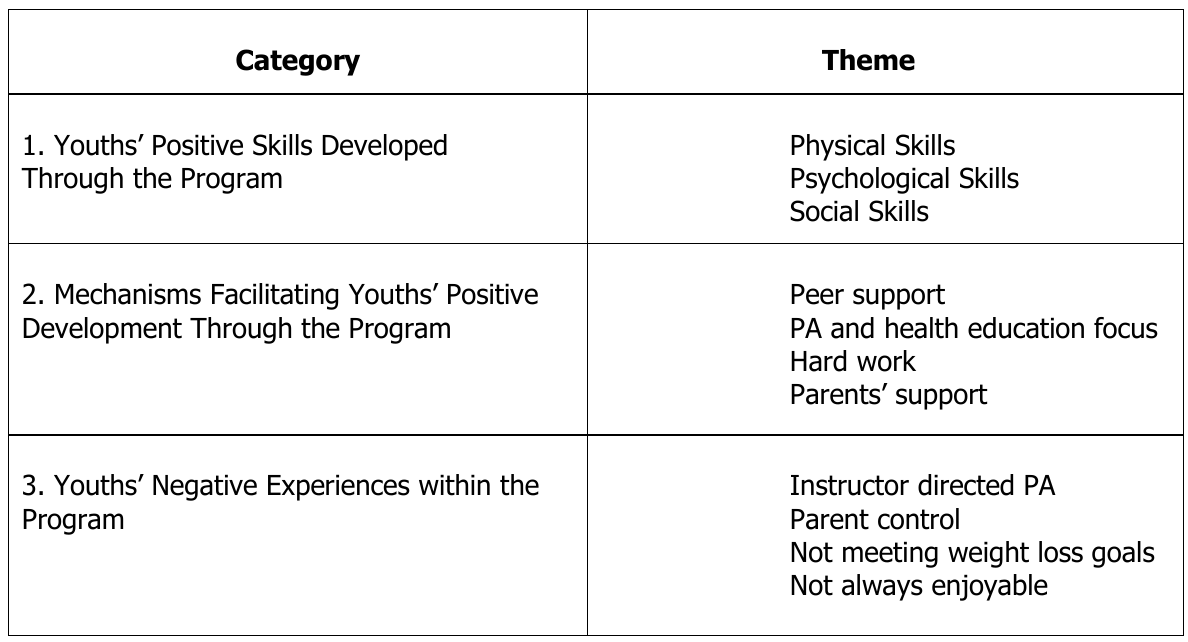
Summary of Results: Categories and